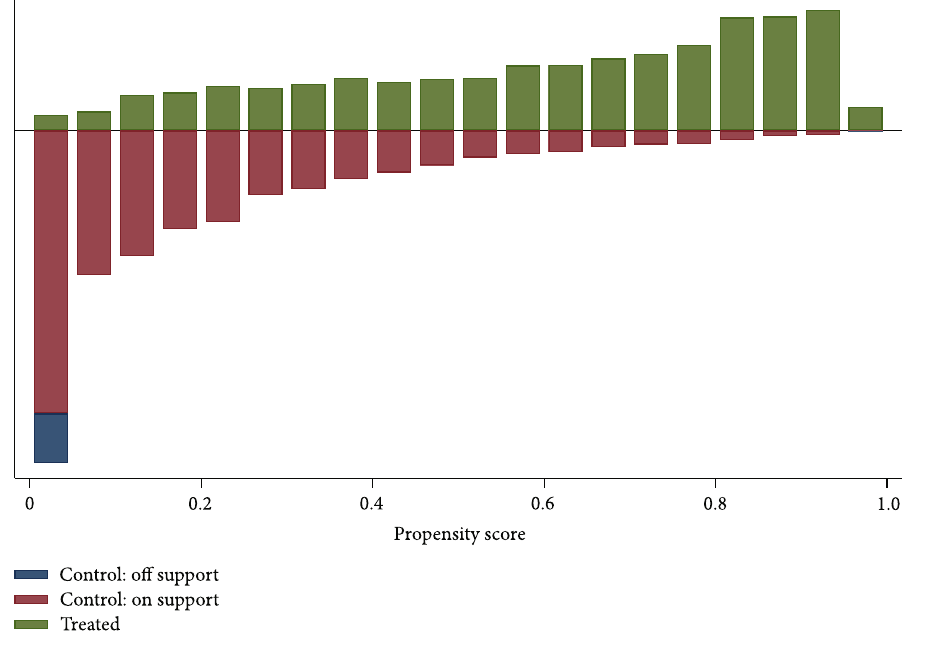
Figure 2: Common range of values for propensity